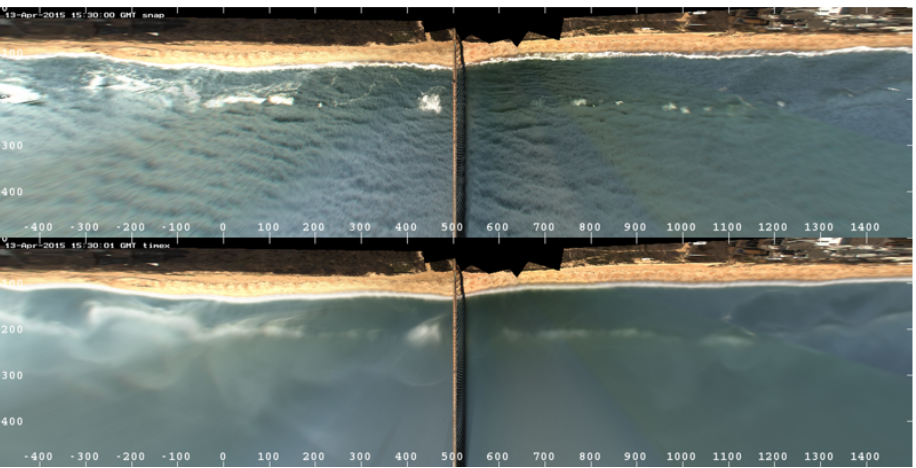
Figure 1. Argus imagery products for 1530 13 April 2015. Images are rectified in a local coordinate system with distance along the coast on the x-axis and distance cross-shore on the y-axis. The top image is a snapshot image in which wave crests and instantaneous wave breaking are visible. The bottom image is a time-averaged (Timex) image for a 10 min period. Bands of white indicate wave breaking